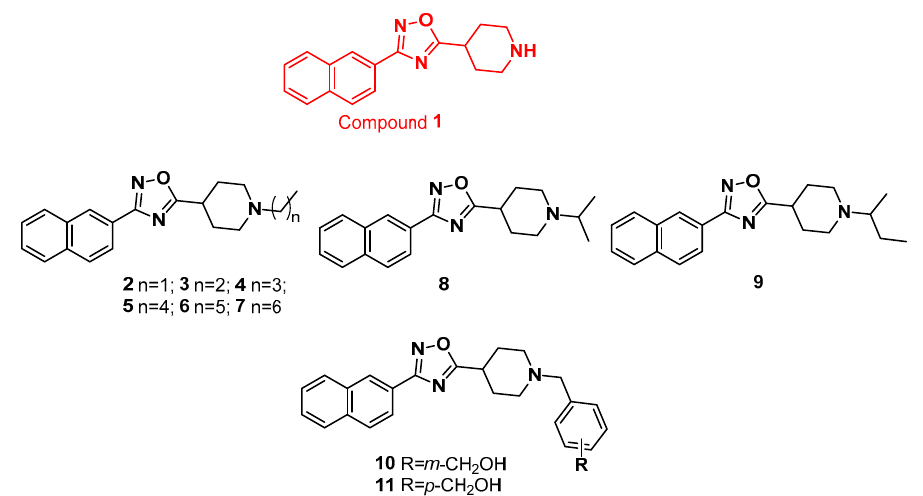
Figure 1. Library of 1,2,4-oxadiazole derivatives generated in this study.